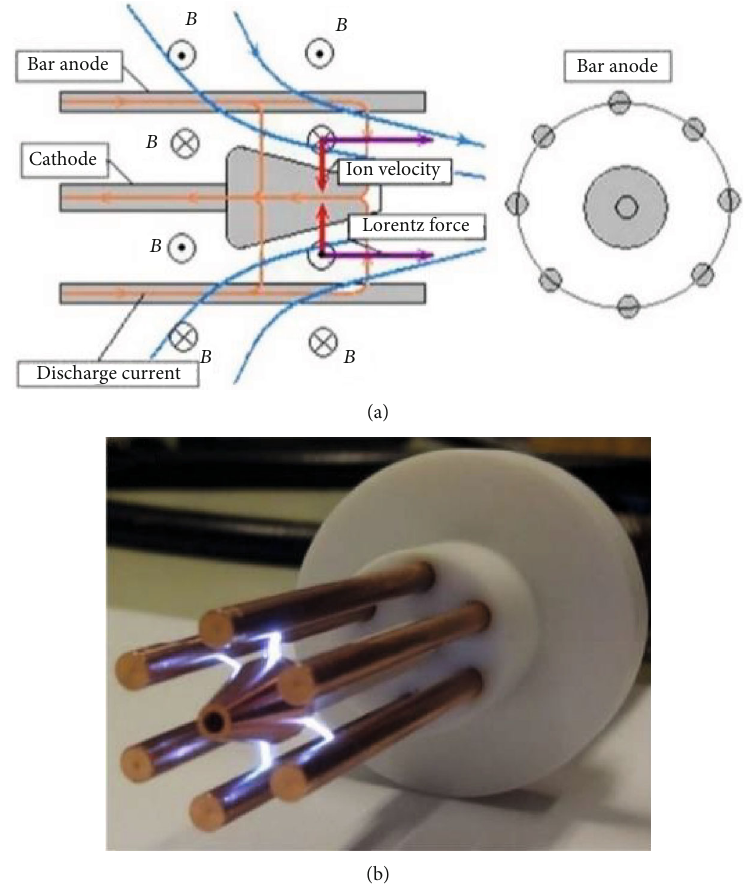
Figure 23: Göksel ’ s AB-MPP: (a) physical principle of magnetoplasma compressors (MPC); (b) photos of transient atmospheric nanosecond pulse discharges for internal MPC excitation [53].